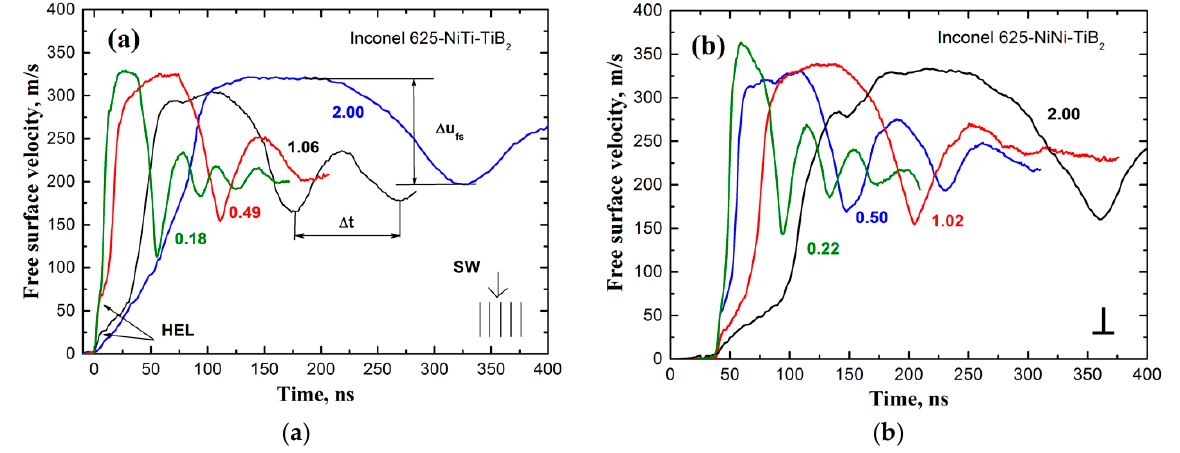
Figure 4. Velocity profiles of the free surface of 95% Inconel 625 + 5%NiTi–TiB 2 alloy samples obtained in the experiments with samples loaded along ( a ) and across ( b ) the deposition direction.